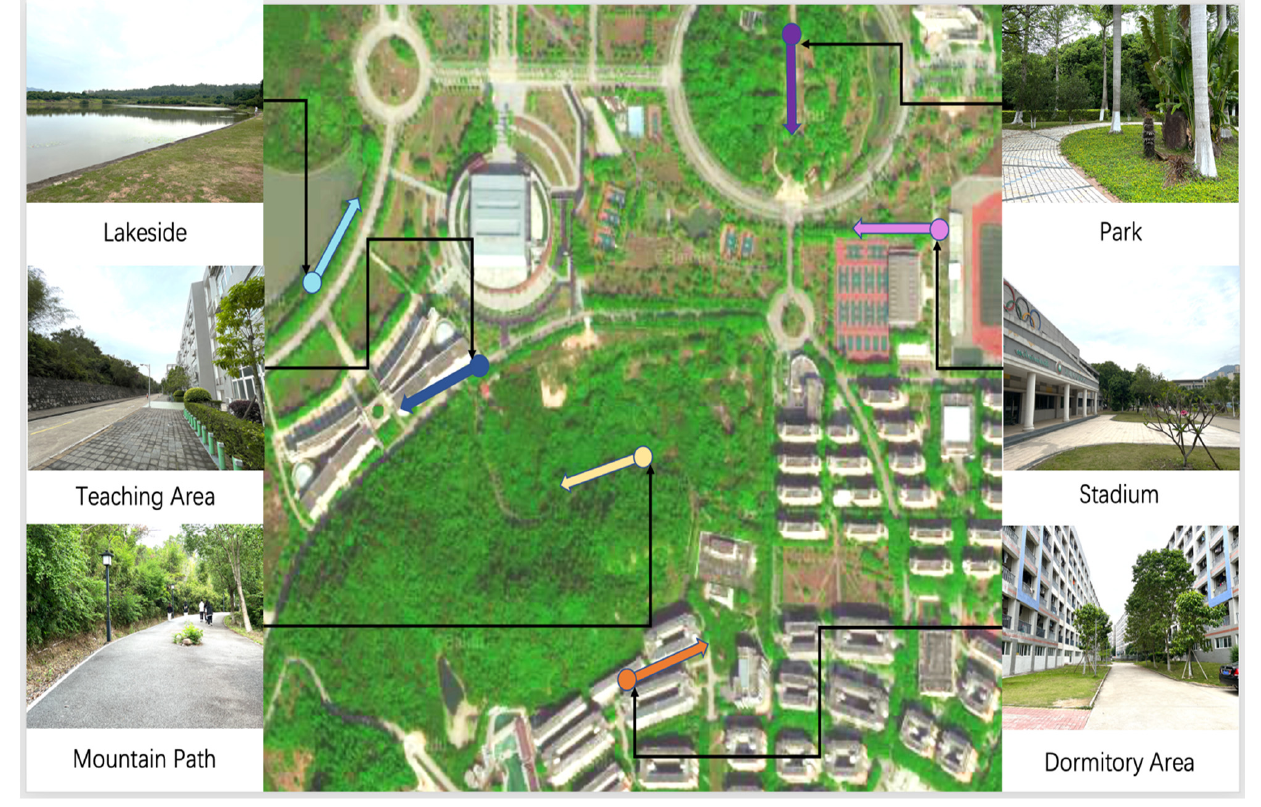
Figure 1. Experimental